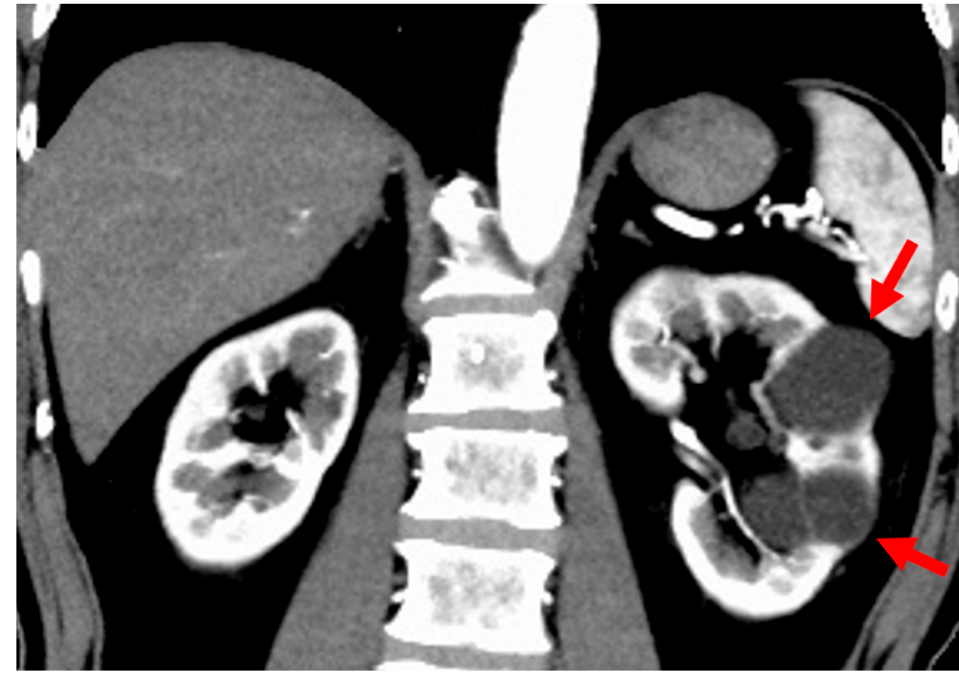
Figure 1. Multiple simple renal cysts: 60s, male, kidney function eGFR 68 mL/min/1.73 m 2 , Bosniak class I (image provided by Shonan Kamakura General Hospital). Several low-density cysts (arrow) on the left kidney.